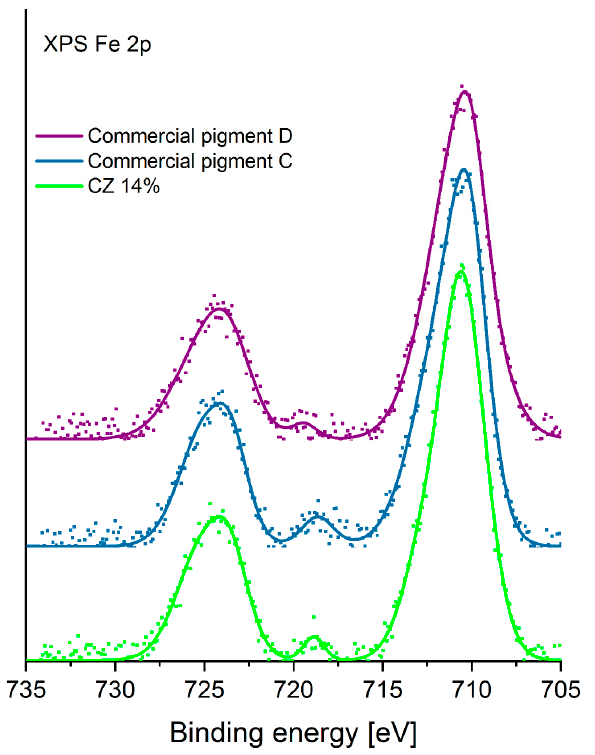
Figure 7. The XPS Fe 2p spectra of CZ 14% and Commercial pigments C and D.